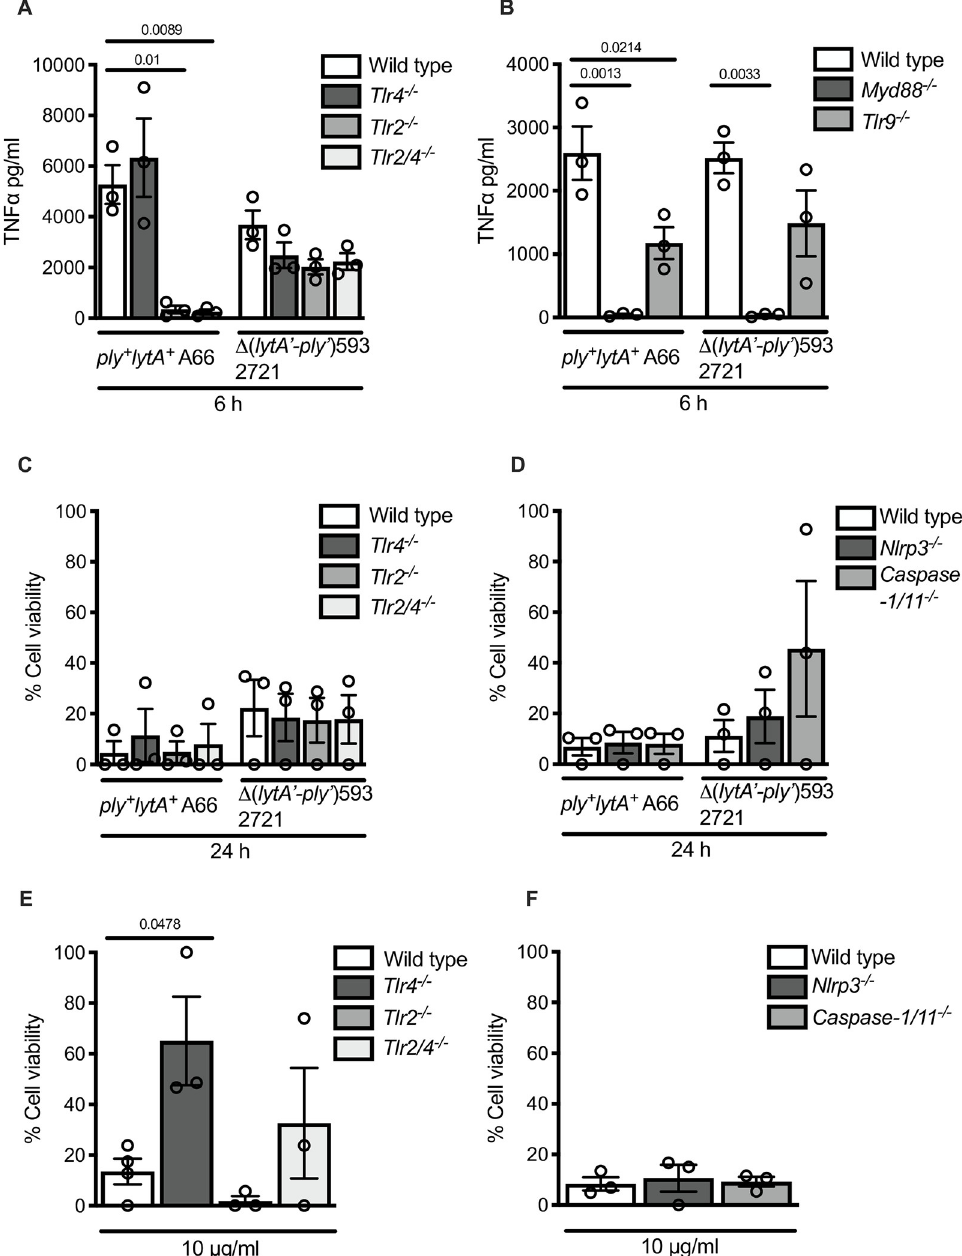
Fig 2. The macrophage inflammatory response to infection with Δ ( lytA’-ply’ )593 pneumococcal strain 2721 is MyD88-dependent, but has limited involvement of other PRR signalling pathways. Primary BMDMs from wild type, Tlr4 -/- , Tlr2 -/- and Tlr2/4 -/- C57Bl/6 mice were infected with ply + lytA + strain A66 or Δ ( lytA’-ply’ )593 strain 2721 at MOI 1 for 6 h. TNF α production in the supernatant was quantified by ELISA analysis (A). Immortalised BMMs from wild type, Tlr9 -/- and Myd88 -/- mice were infected with Δ ( lytA’-ply’ )593 strain 2721 and ply + lytA + strain A66 at MOI 1 for 6 h (B). Primary BMDMs from wild type, Tlr4 − / − , Tlr2 − / − and Tlr2/4 − / − mice were either infected with ply + lytA + strain A66 or Δ ( lytA’-ply’ )593 strain 2721 at MOI 5 for 24 h (C) or stimulated with pneumolysin at 10 μ g/ml for 24 h and cell viability was measured by the LDH cytotoxicity assay (E). Primary BMDMs from wild type, Nlrp3 -/- , Caspase 1 − / − (Caspase 11 − / − ) C57Bl/6 mice were either infected with Δ ( lytA’-ply’ )593 strain 2721 or ply + lytA + strain A66 at MOI 10 for 24 h (D) or stimulated with purified pneumolysin at 10 μ g/ml for 24 h (F) and cell viability was measured by the LDH cytotoxicity assay. Data depicted are the raw values, with the mean and SEM from three independent experiments. Statistical analysis: one-way ANOVA with Dunnet’s post-test, adjusted P-values reported.